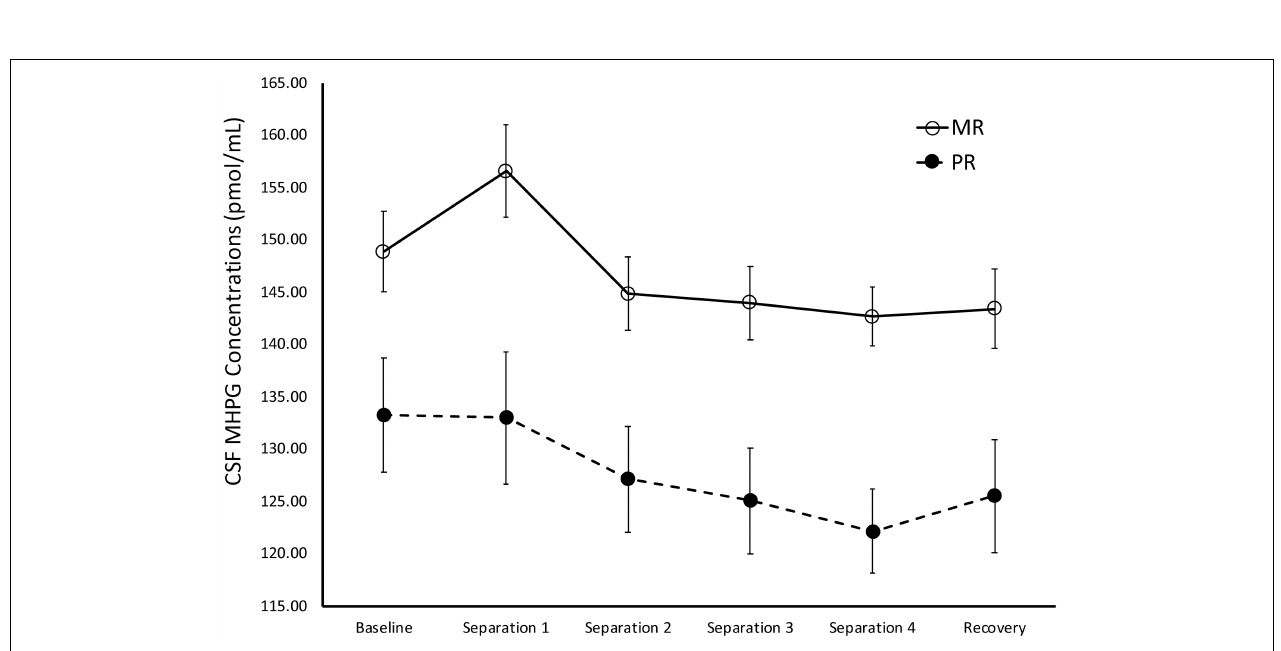
FIGURE 3 | Rearing effects on baseline and stress-induced CSF MHPG concentrations. Depicts the relationship between rearing condition and CSF MHPG concentrations during Baseline , Separations 1–4 , and Recovery . There was a significant main effect of time on CSF MHPG concentrations [ F (1,141) = 10.21, p = 0.002], with CSF MHPG concentrations higher during Baseline and Separations 1 and 2 , when compared to Separations 3 and 4 or Recovery . There was also a significant main effect of rearing [ F (1,141) = 14.15, p < 0.0001], with MR subjects exhibiting higher CSF MHPG concentrations at Baseline , Separations 1–4 , and Recovery, when compared to PR subjects. MR subjects are represented by white circles and solid lines, PR subjects are represented by black circles and dashed lines.